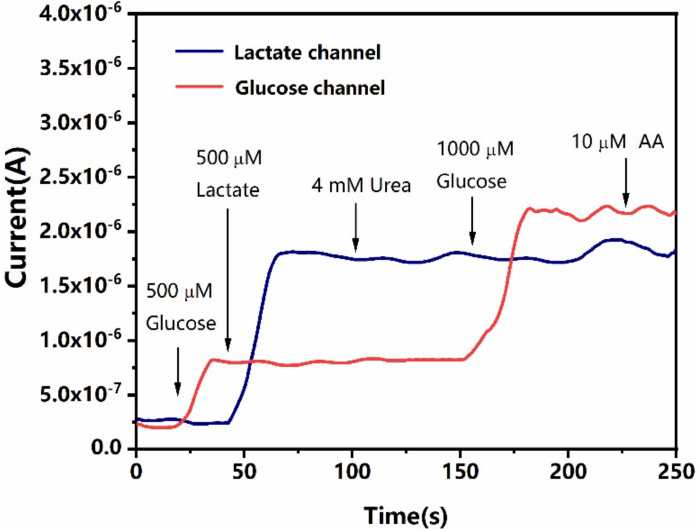
Figure 5. Current response from the two channels of the electrochemical biosensor. The arrows show the time points at which the analytes (glucose and lactate) and interfering substances were added into the electrolytic cell. Current response measured by amperometric I-t test was